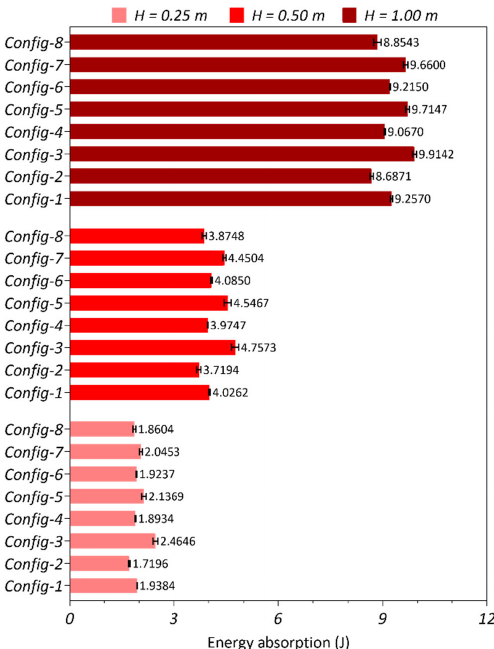
Figure 5. Energy absorbing capacities for configurations.